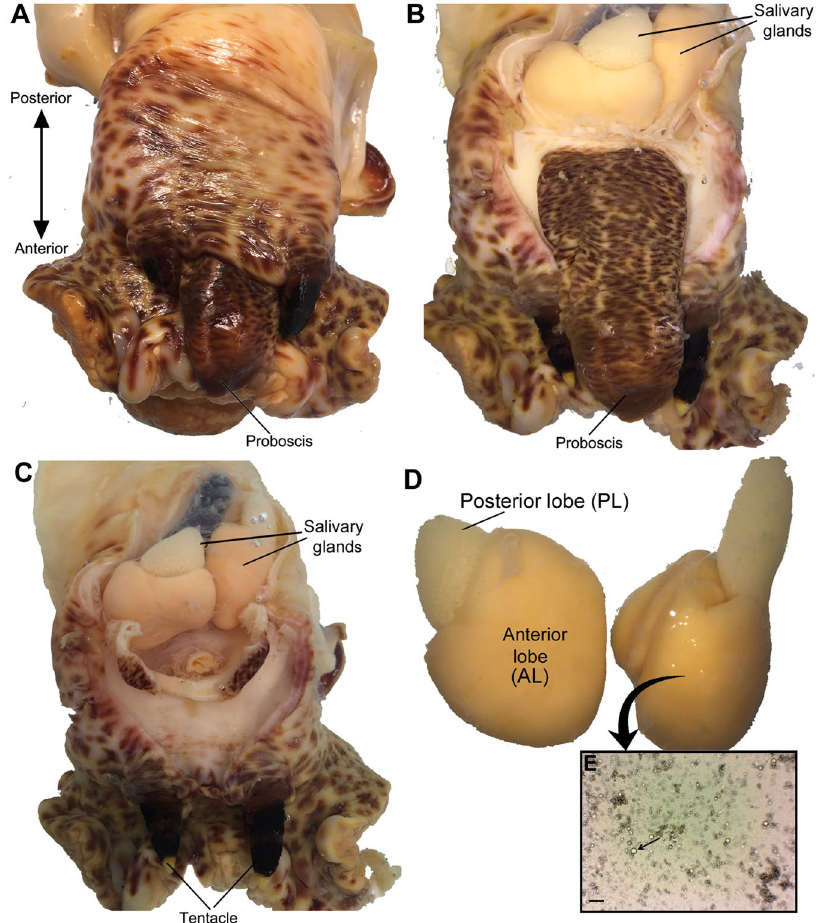
Figure 2. Charonia tritonis salivary gland (SG) anatomy and proteomics study. ( A ) Cephalic region of the C. tritonis . ( B ) Cephalic region with full proboscis and paired SGs exposed. ( C ) Cephalic region with proboscis removed. ( D ) Isolated SG showing region of anterior lobe (AL) and posterior lobe (PL). ( E ) Cell smear of AL. Arrow shows prominent mucin-like globlet cell. Scale bar represents 200 μ m.